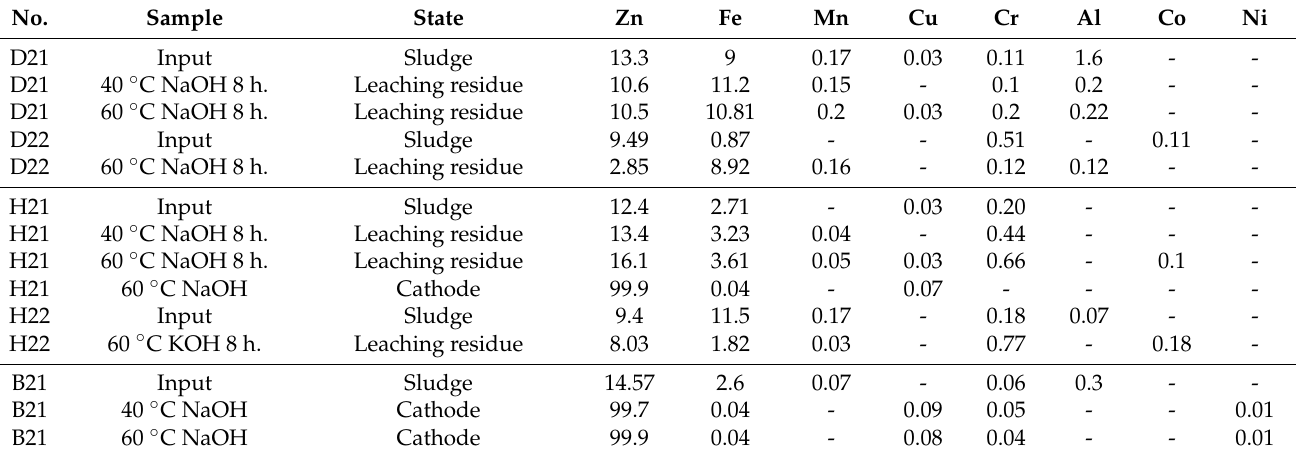
Table 17. The results of ED-XRF analyses of the input galvanic sludge, leaching residues and cathode zinc after the electrolysis. (Note: average values of three measurements over 300 ppm)